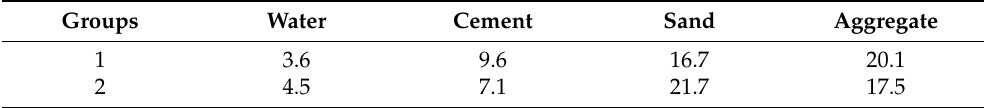
Table 1. Proportion of concrete (kg).